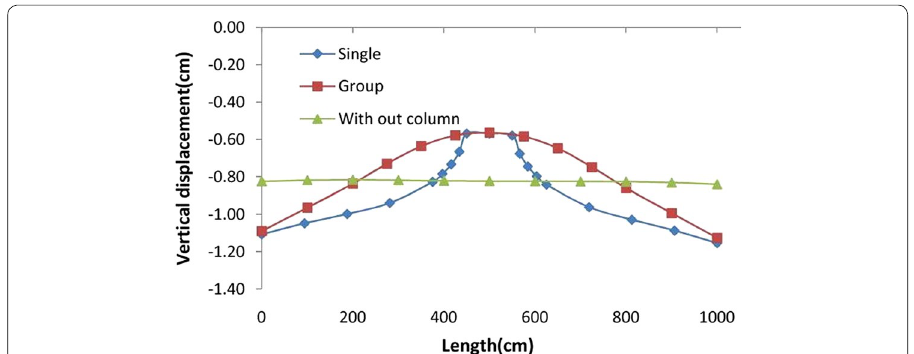
Fig. 24 Soil longitude profile at ground surface in the level passing from center of model with implementa‑ tion of